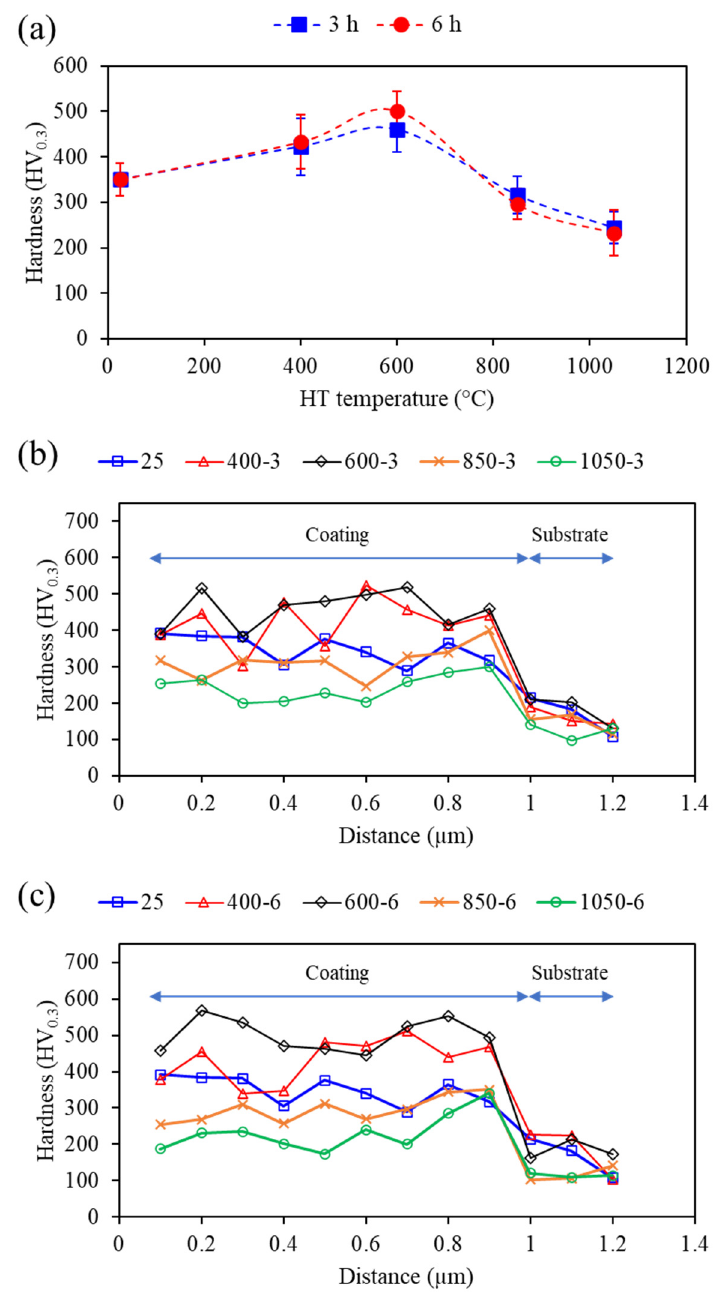
Figure 9. ( a ) Average coating hardness as a function of heat treatment temperature, and coating hardness profile across the sample cross-section for heat treated samples of ( b ) 3 h and ( c ) 6 h hold durations.